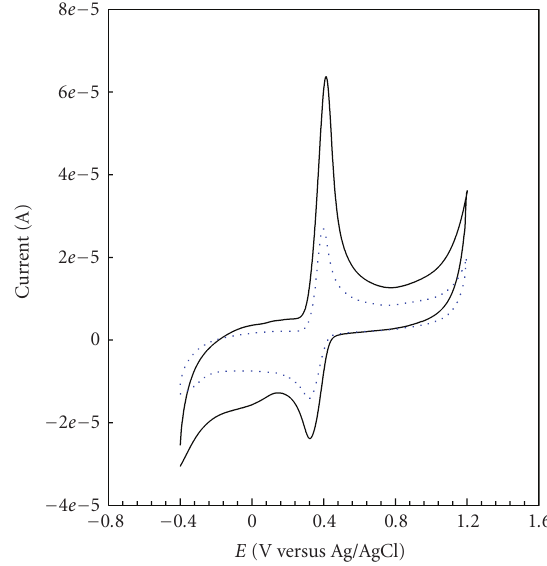
Figure 4: Cyclic voltammograms of 0.1 mM AC on the surface of oppy/MWCNT/GCE in pH = 7 various polymerization counter ion; KCl (dotted line), and HQSA (solid